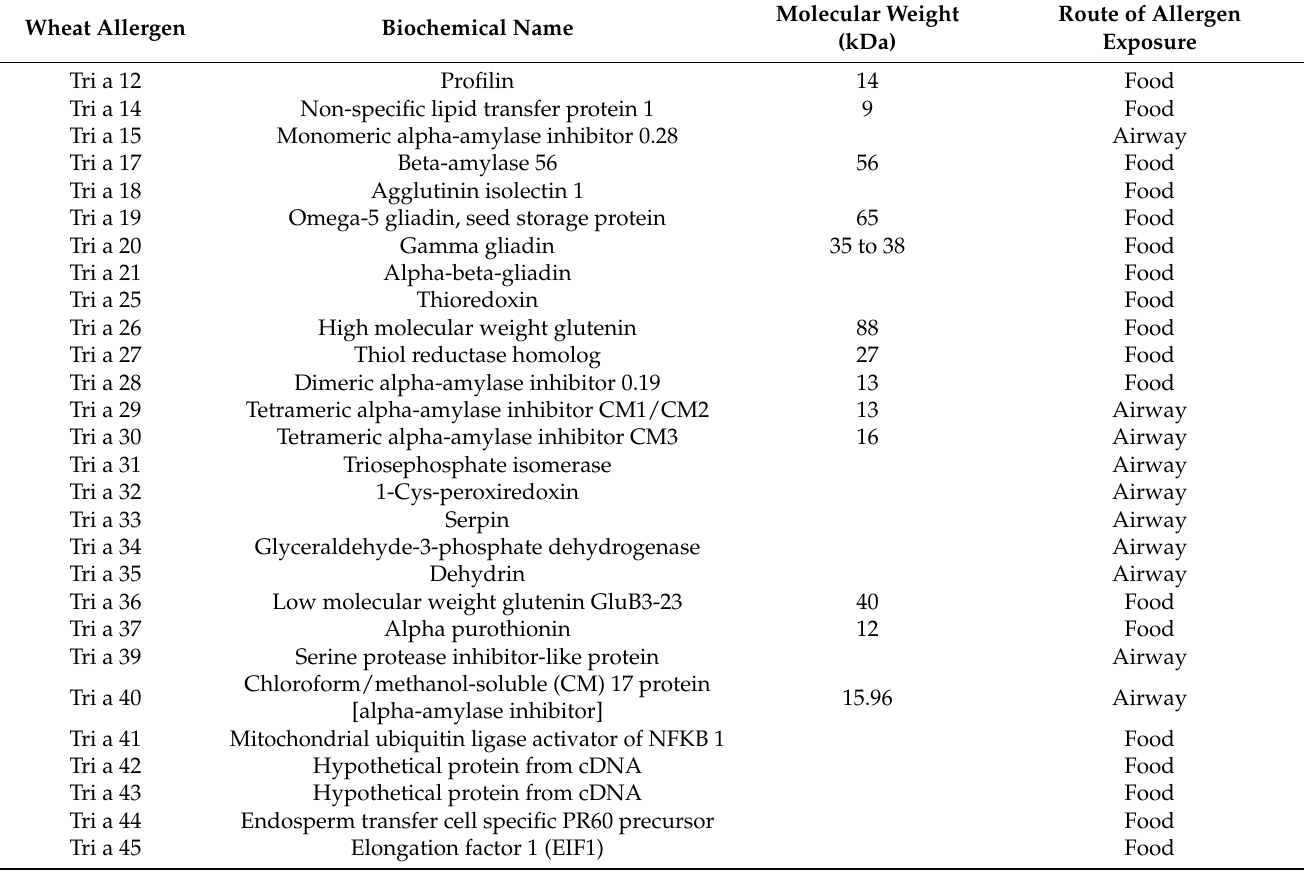
Table 2. Wheat proteins implicated in IgE-mediated wheat allergy. Source: www.allergen.org (accessed on 19 July 2021). Wheat